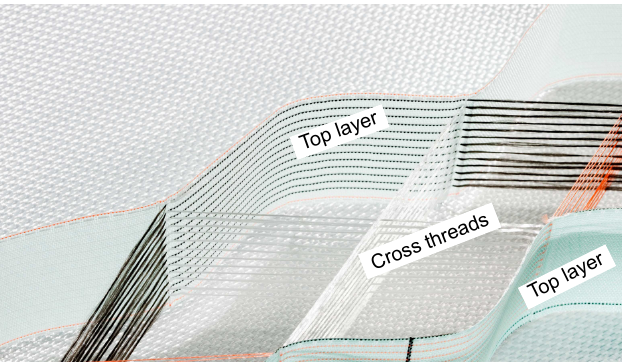
Figure 4. Cross-section of a flat, rectangular, pressurized woven structure or woven mattress (source: Global Safety Textiles).